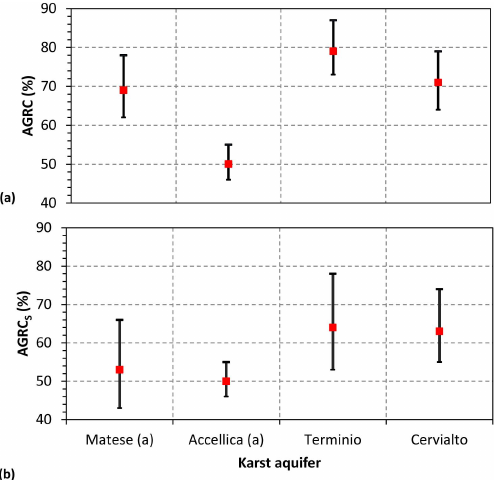
Fig. 7. AGRC (a) and AGRC S (b) estimations for the four sam- ple karst aquifers obtained considering uncertainties of the annual P − ETR and air temperature regression models (95% confidence